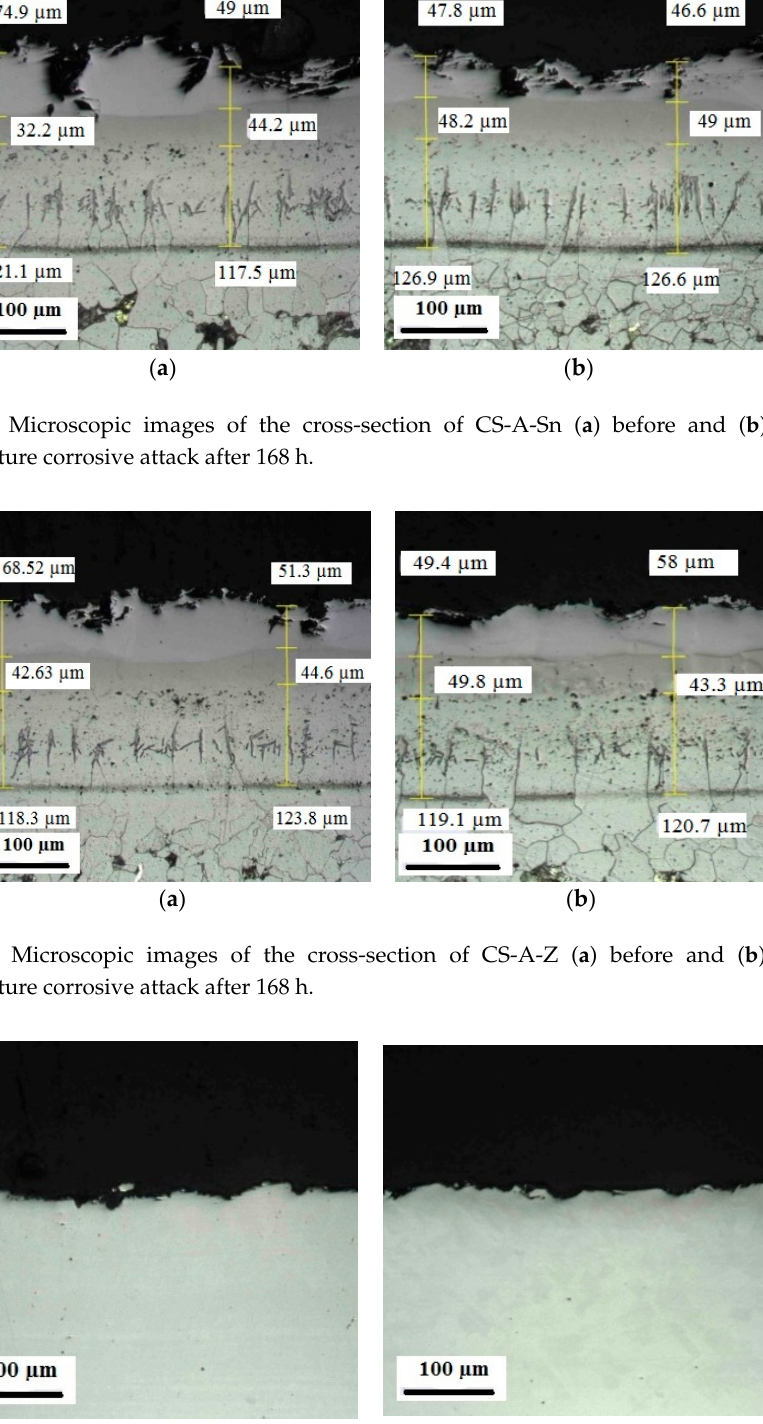
Figure A10. Microscopic images of the cross-section of 316-Bare ( a ) before and ( b ) after the low-temperature corrosive attack after 168 h.